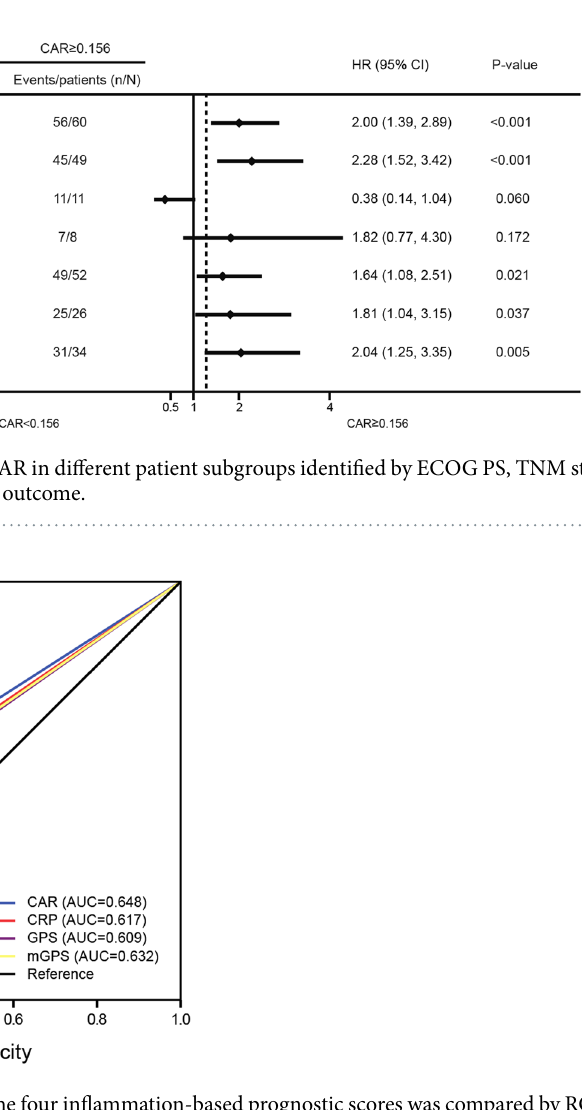
Figure 5. The predictive ability of the four inflammation-based prognostic scores was compared by ROC